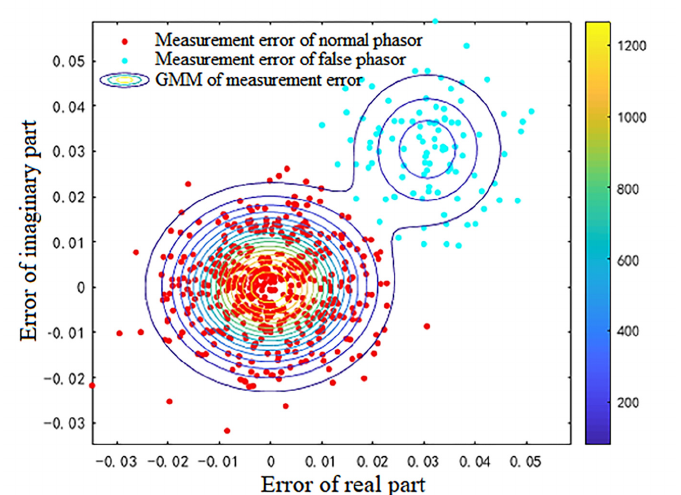
Figure 3. The processing results of the EM algorithm.